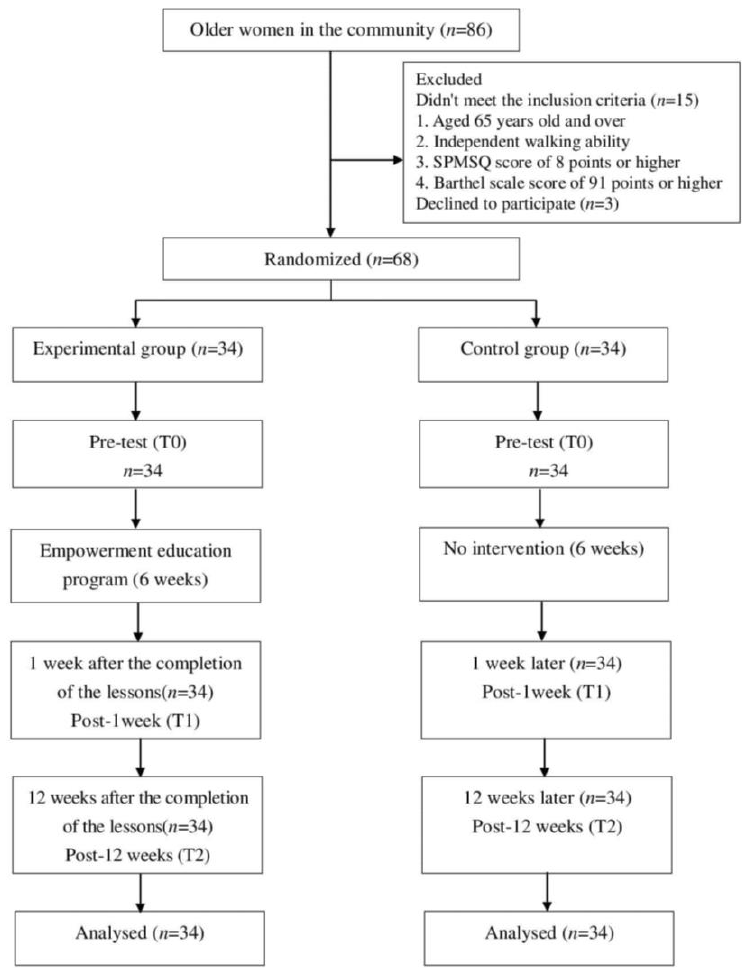
Figure 1. Flow diagram. Figure 1. Flow Table 1. Empowerment education program.